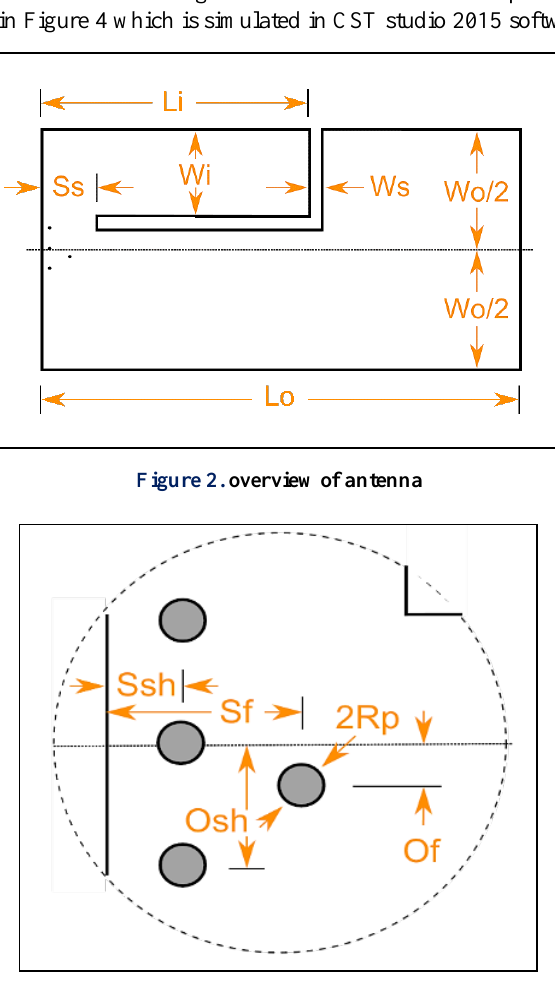
Figure 3. Shorting pins and feeding